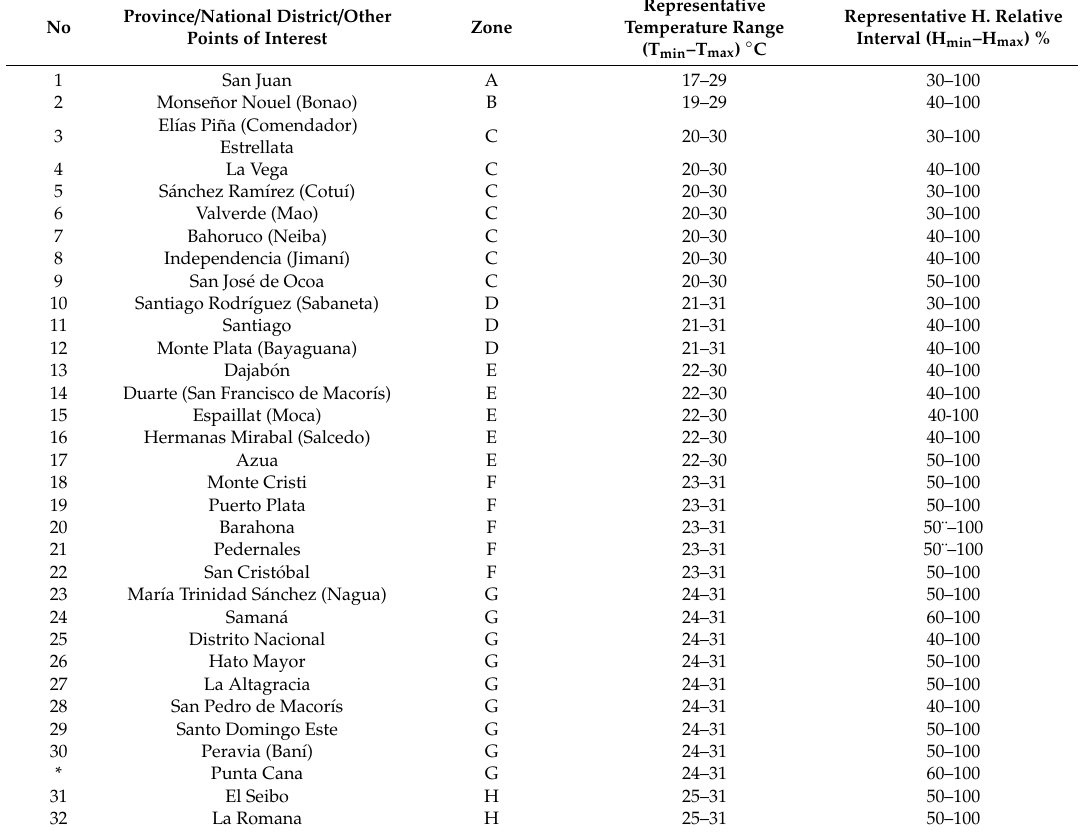
Table 4. Classification of province types by air temperature and relative humidity.